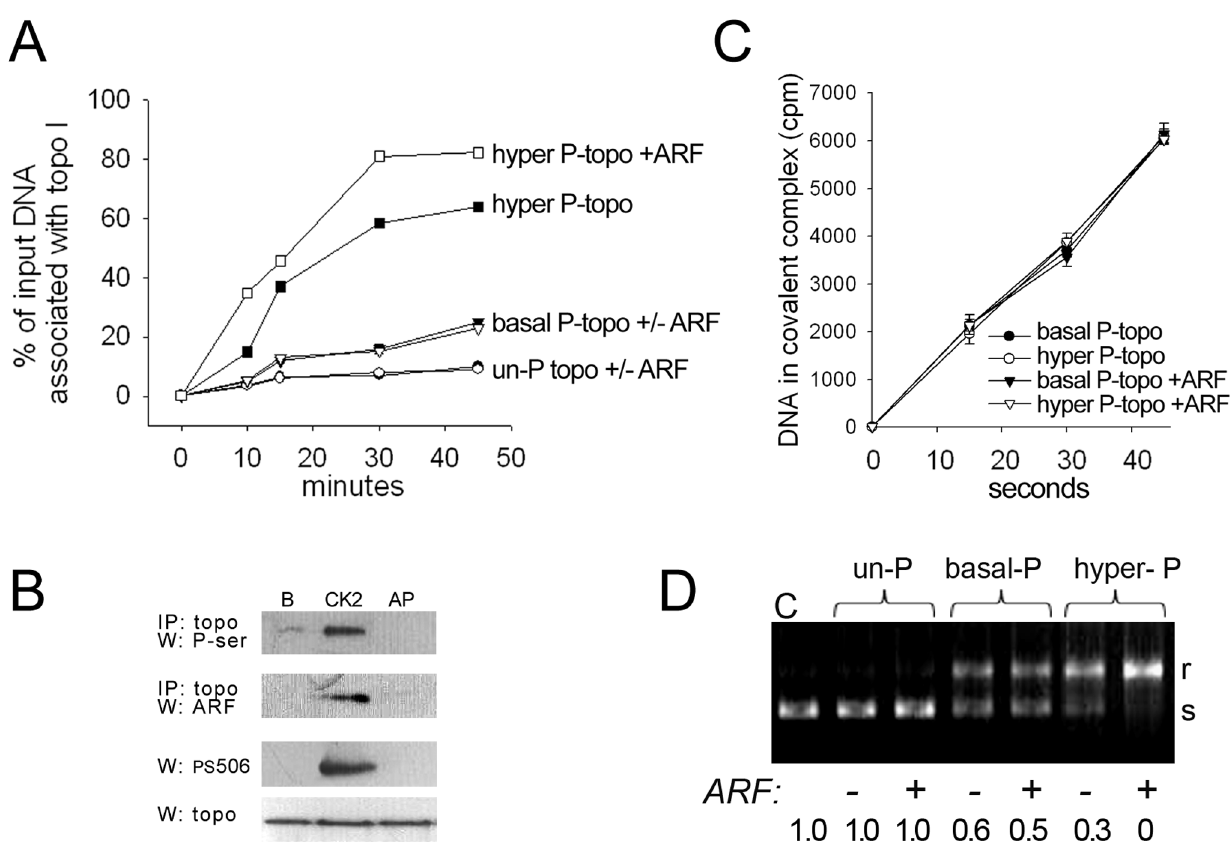
Figure 2. Effects of topo I phosphorylation status and ARF on topo I DNA association and relaxation activity. (A) Time course of non- covalent association [low salt (75 mM NaCl) at 4 u C] of various R-topo I forms (0.3 pmol) with 0.03 pmol [ 3 H]-labeled plasmid DNA in the presence or N absence of 0.3 pmol bacterially produced human ARF fusion protein: hyperphosphorylated topo I minus ARF ( & ) or plus ARF ( % ); basal ) or plus ARF ( # ). (B) Row 1: Topo I phosphorylated topo I minus ARF ( . ) or plus ARF ( , ); and unphosphorylated (AP-treated) topo I minus ARF ( immunoprecipitation (IP) with basal phosphorylated (lane ‘‘B’’), hyperphosphorylated (lane ‘‘CK2’’), and unphosphorylated (lane ‘‘AP’’) R-topo I (1 m g) followed by phosphoserine Western; row 2: topo I IP of basal phosphorylated, hyperphosphorylated, or unphosphorylated R-topo I (1 m g) incubated with 0.14 m g ARF, followed by ARF Western; rows 3 and 4: Western analyses of PS506 and total topo I, respectively, with the same basal phosphorylated, hyperphosphorylated, and unphosphorylated R-topo I samples as in rows 1 and 2 (0.3 m g per lane) ( C ) Rate of topo I-catalyzed nicking of a radiolabeled suicide substrate that traps topo I and DNA in a covalent complex. Non-covalent complexes of DNA with basal or hyperphosphorylated R-topo I were preformed by incubation in low salt at 4 u C in the presence or absence of recombinant ARF, then the temperature was raised to 8 u C for the indicated times. Covalently linked DNA-topo I complexes were recovered by precipitation with K + SDS and quantified by scintillation counting. (D) Topo I-mediated plasmid relaxation assay performed with unphosphorylated, basal phosphorylated, and hyperpho- sphorylated R- topo I, followed by agarose gel electrophoresis to separate substrate and products; s=supercoiled, r=relaxed plasmid DNA.